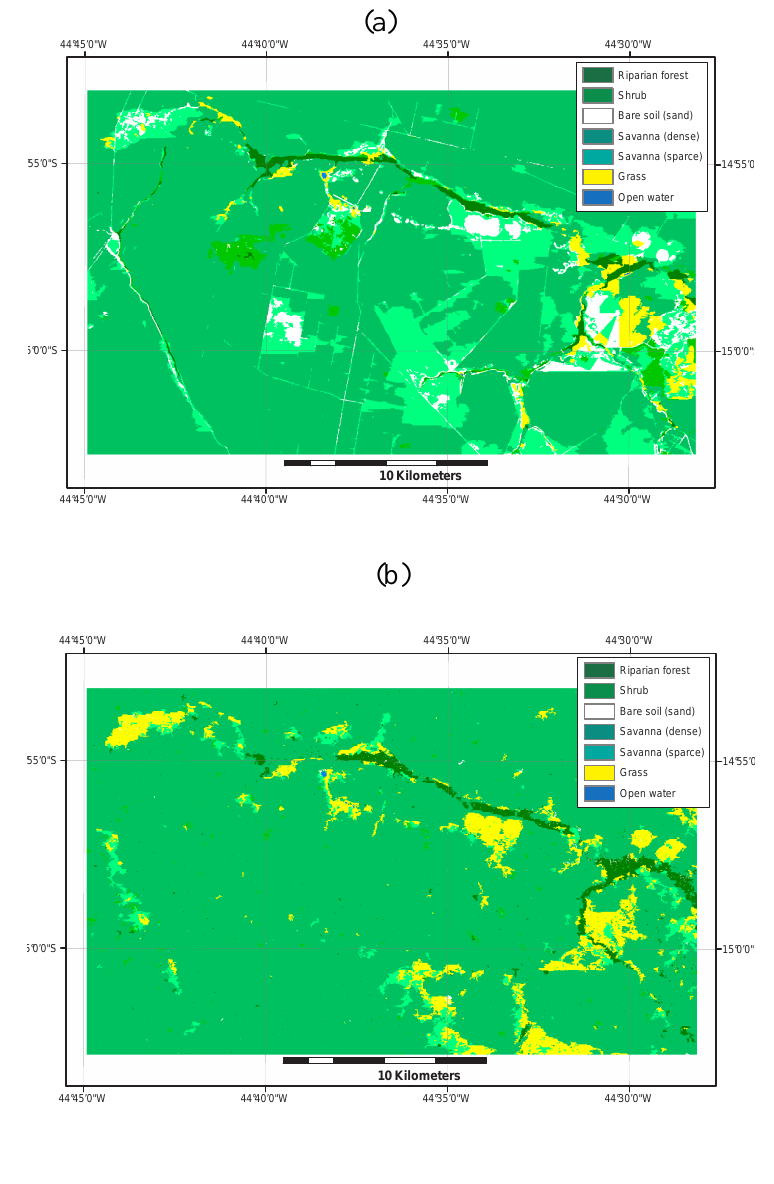
Figure 6. Results obtained from the classification of the vegetation types a) with the ASTER image (VNIR only) and b) with the four Radarsat-1 scenes